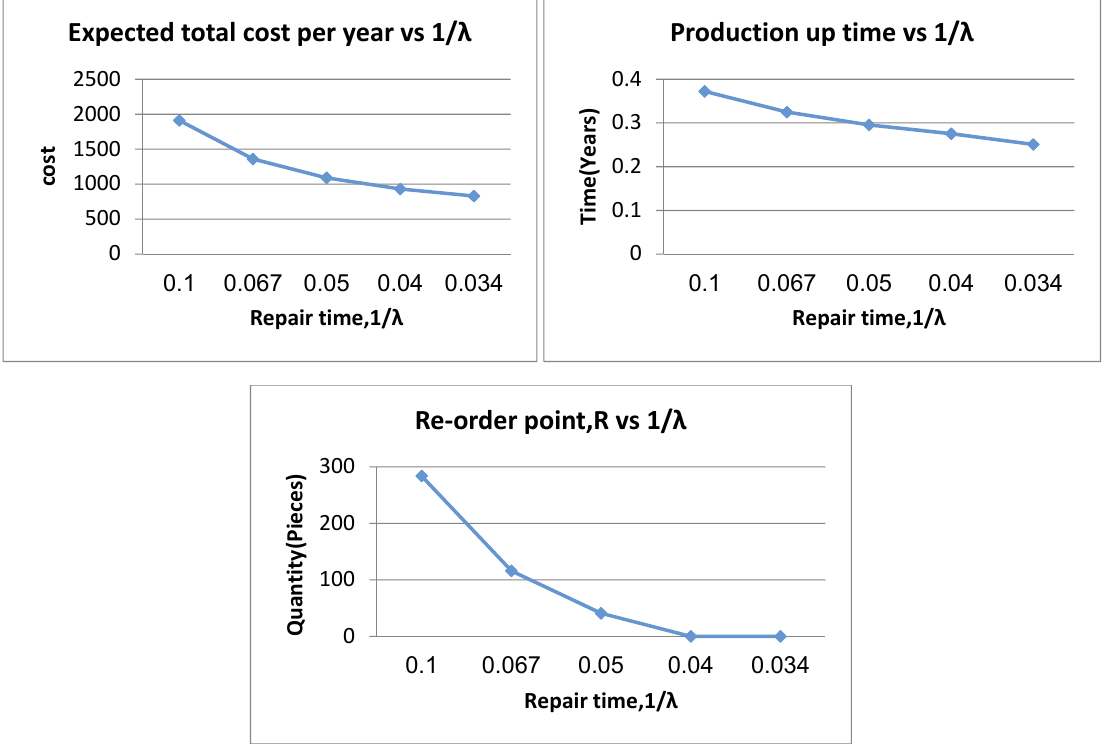
Fig. 11. Expected total cost per year, up time & reorder point for different value of 1/